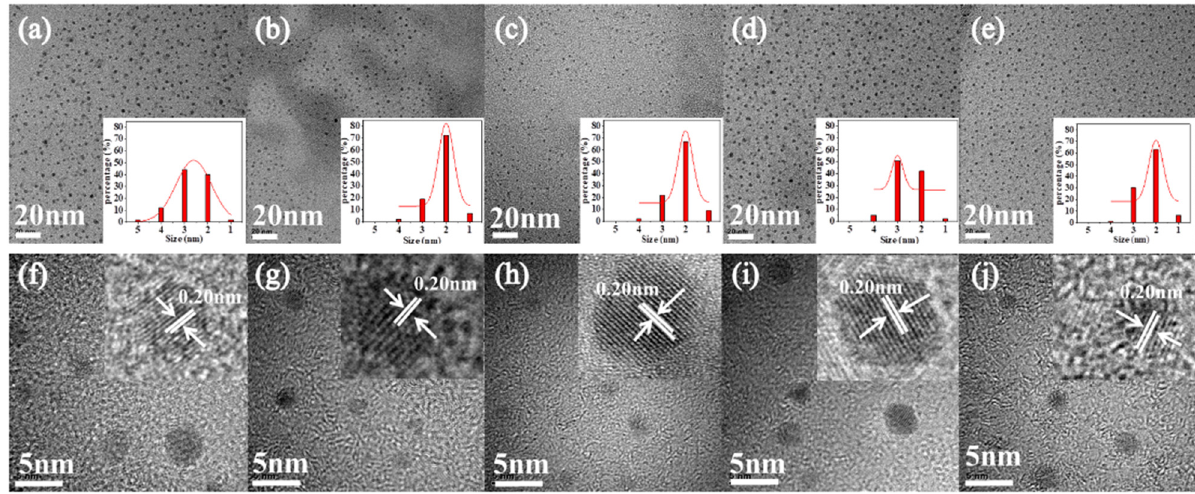
Figure 4. ( a – e ) TEM images of CDs (from left to right). The insets show histograms and Gaussian fits to the particle-size distributions of these CDs. ( f – j ) HR-TEM images of CDs (from left to right).